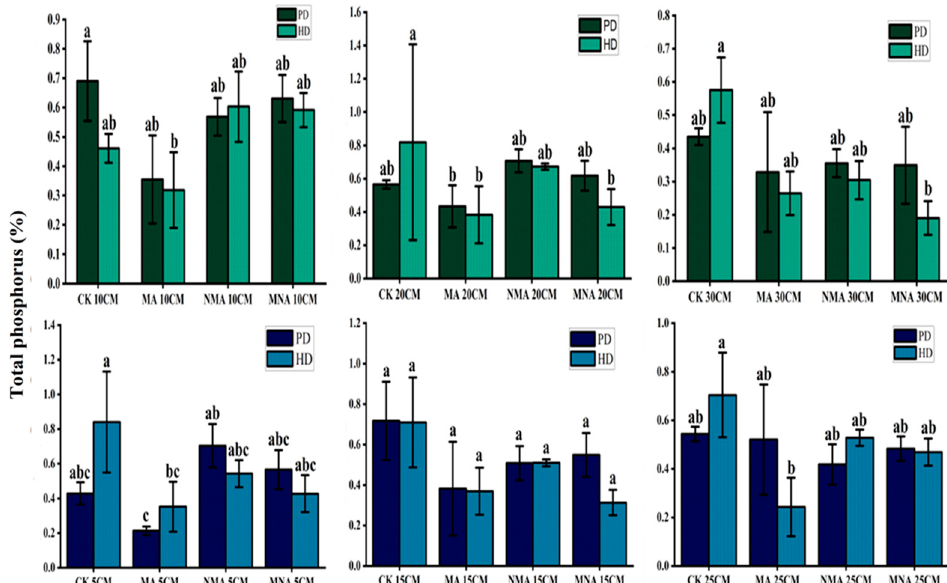
Figure 8. Effects of soil depth ( top row ) and distance from plant trunk ( bottom row ) on soil total phosphorus content. The bars are the standard error of the replications while the different letters on the bars indicate significant differences at p < 0.05.